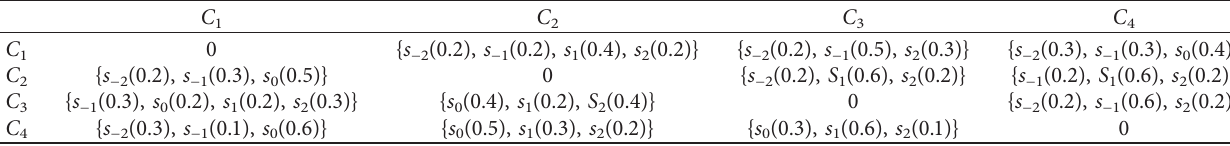
Table 1: Comprehensive direct influencing matrix Q .